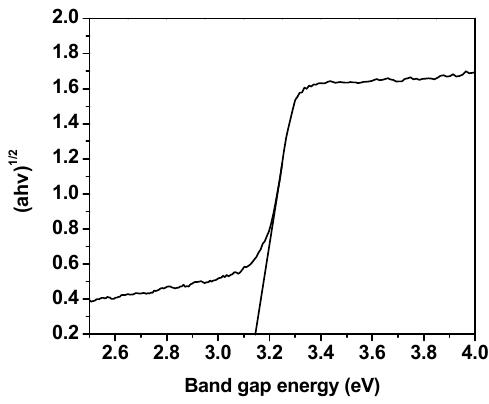
Figure 6. Optical property of the PZ ‐ 17 hybrid film photocatalyst.